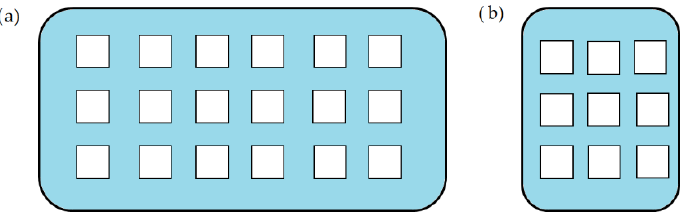
Figure 8. Cross-section of the 3D-printed channeled tablets. Each white square represents a channel. ( a ) Channels parallel to the longer side; ( b ) channels parallel to the shorter side [52]. Scoutaris et al. created indomethacin (as a model drug) containing PEG filaments,